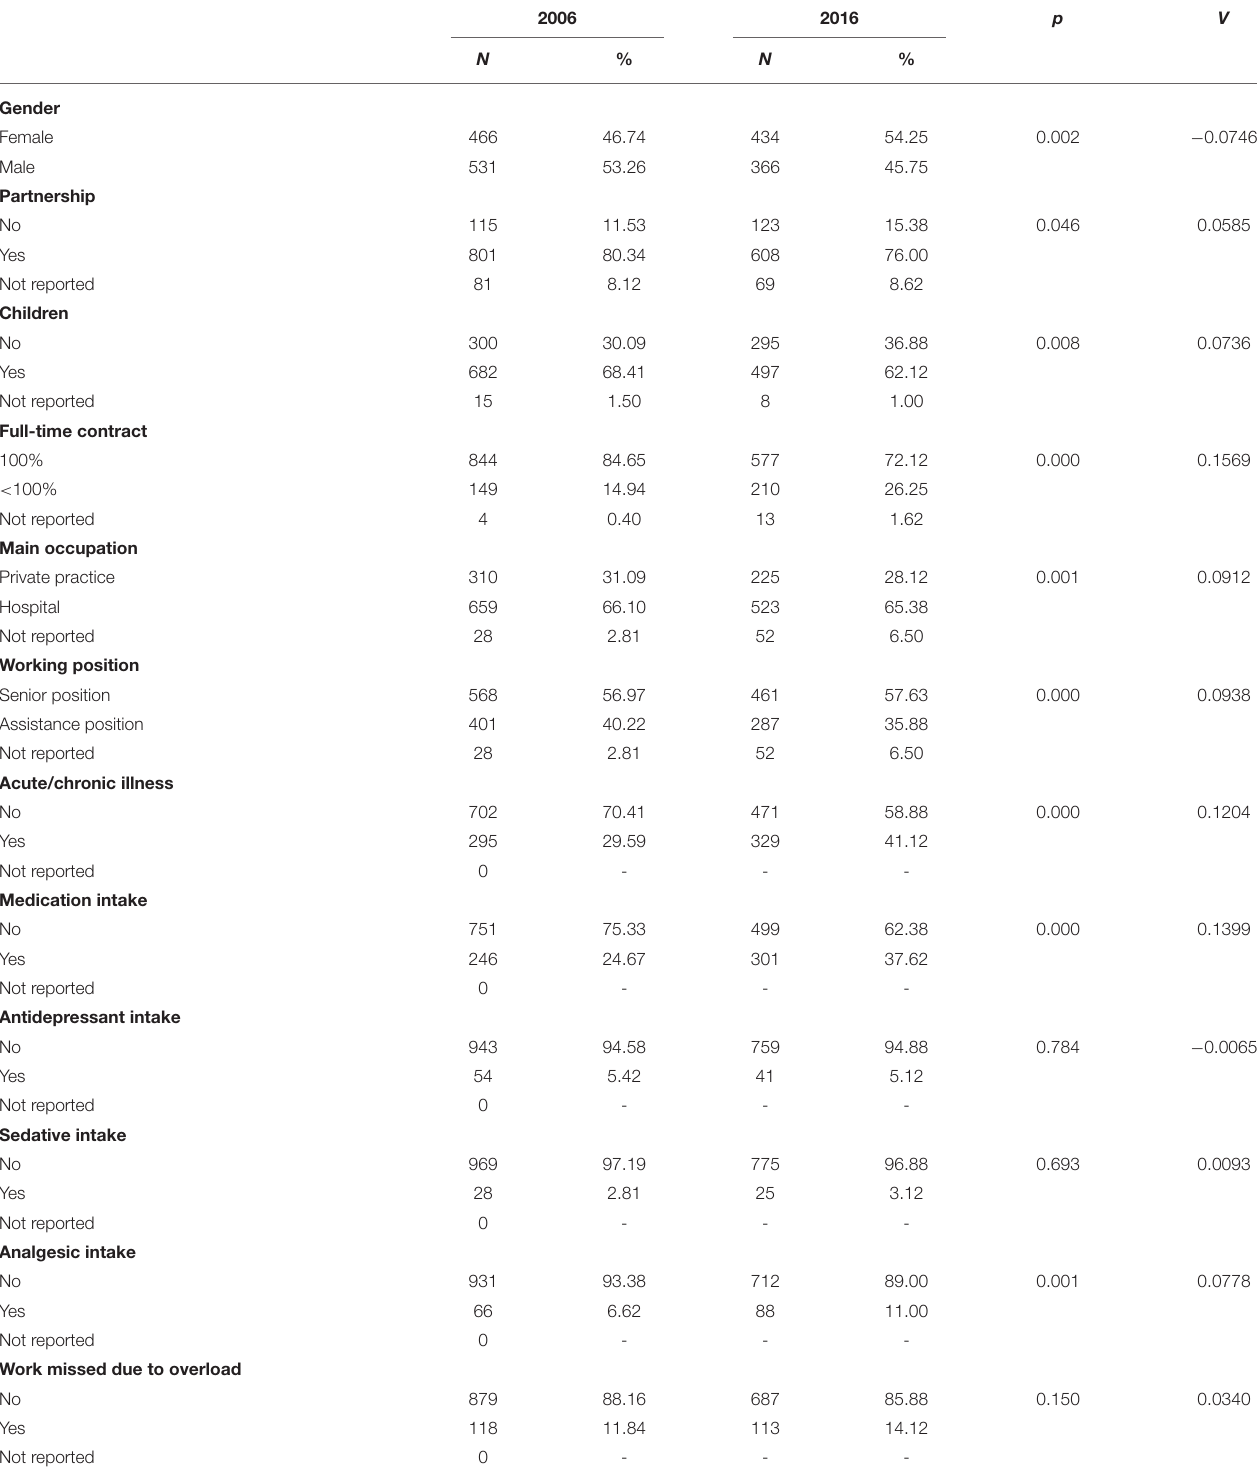
TABLE 1 | Comparison of family, occupational and health